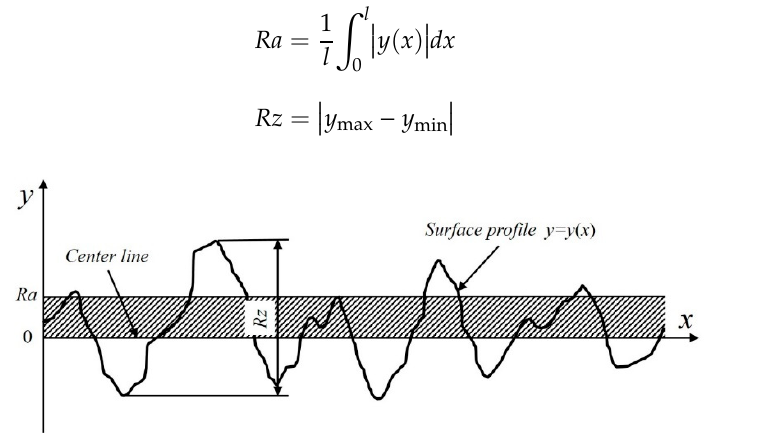
Figure 2. Microstructure of wear.